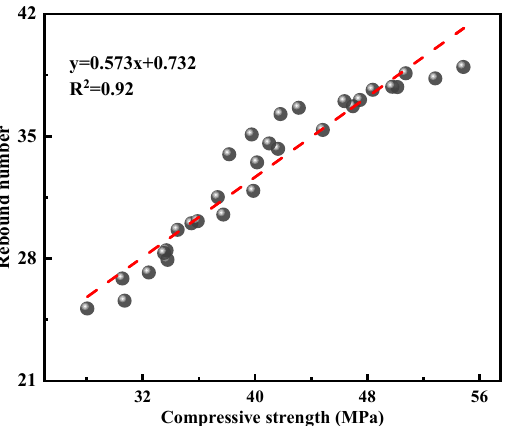
Figure 9. The relationship between the rebound number and compressive strength.